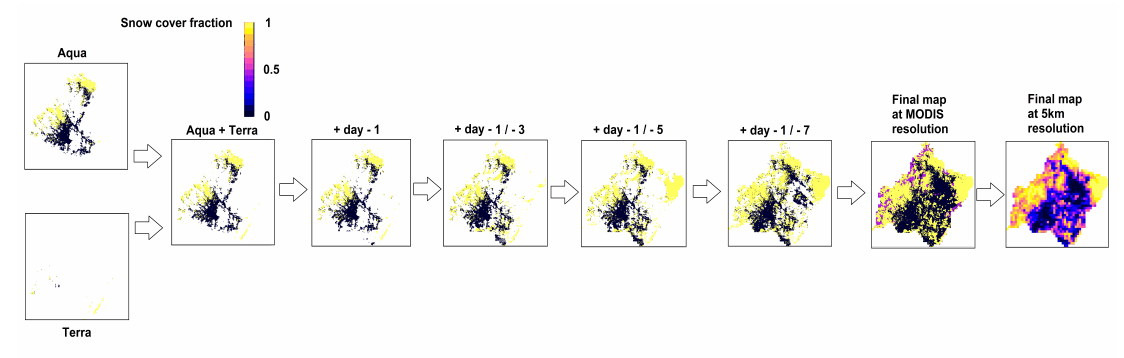
Figure 1. The differents steps for merging MODIS maps. The Snow Cover Area ( i.e. , SCA) is shown here, from 0 for no snow to 1 for pixels entirely covered by snow. Details are given in the text in Section